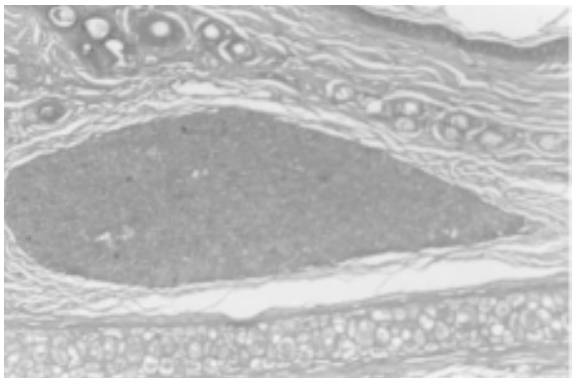
FIGURA 1 - Fotomicrografia mostrando congestªo venosa e edema perivascular.